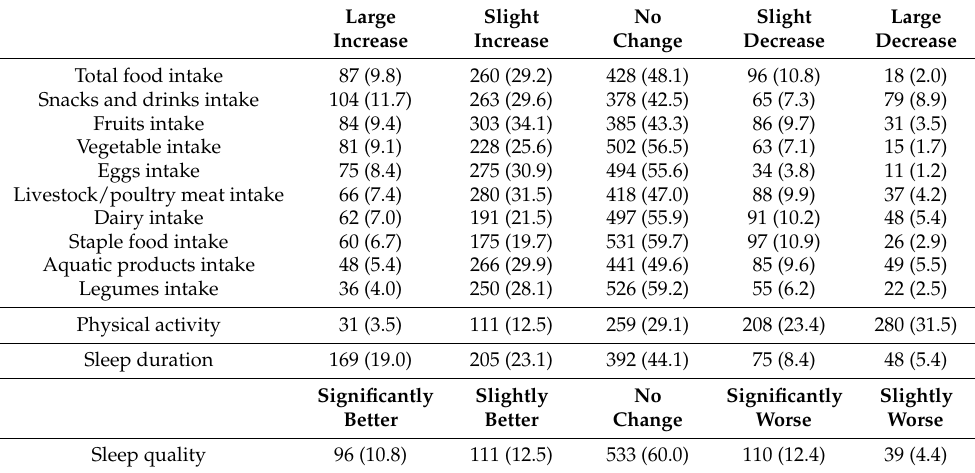
Table 1. Changes in food intake, physical activity, and sleep compared to before the COVID-19 outbreak.